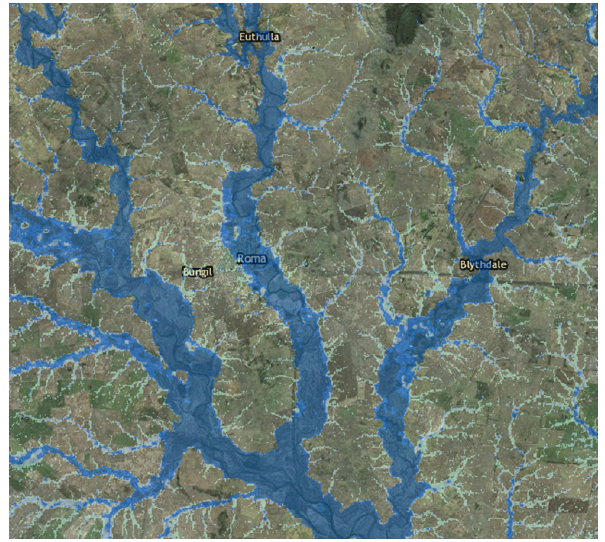
Figure 6. Basin-level flood modelling for Bungil Creek (Queens- land Department of Natural Resources and Mines, 2015).